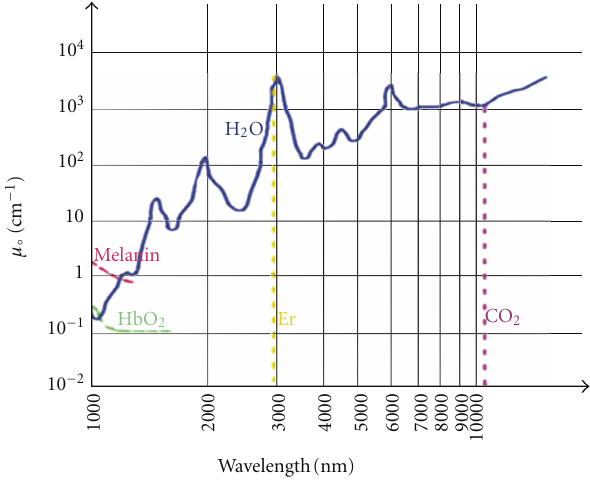
Figure 10: Water absorption coe ffi cient in the infrared